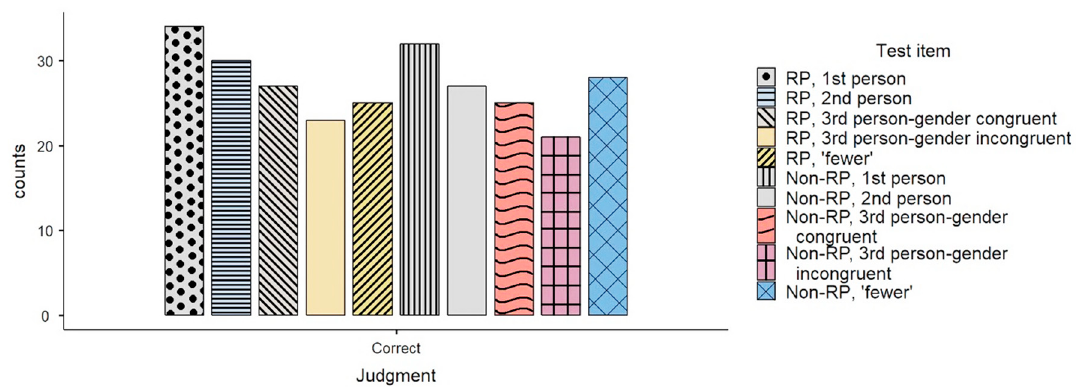
Figure 7. Counts of judgment ‘correct’ per test item.